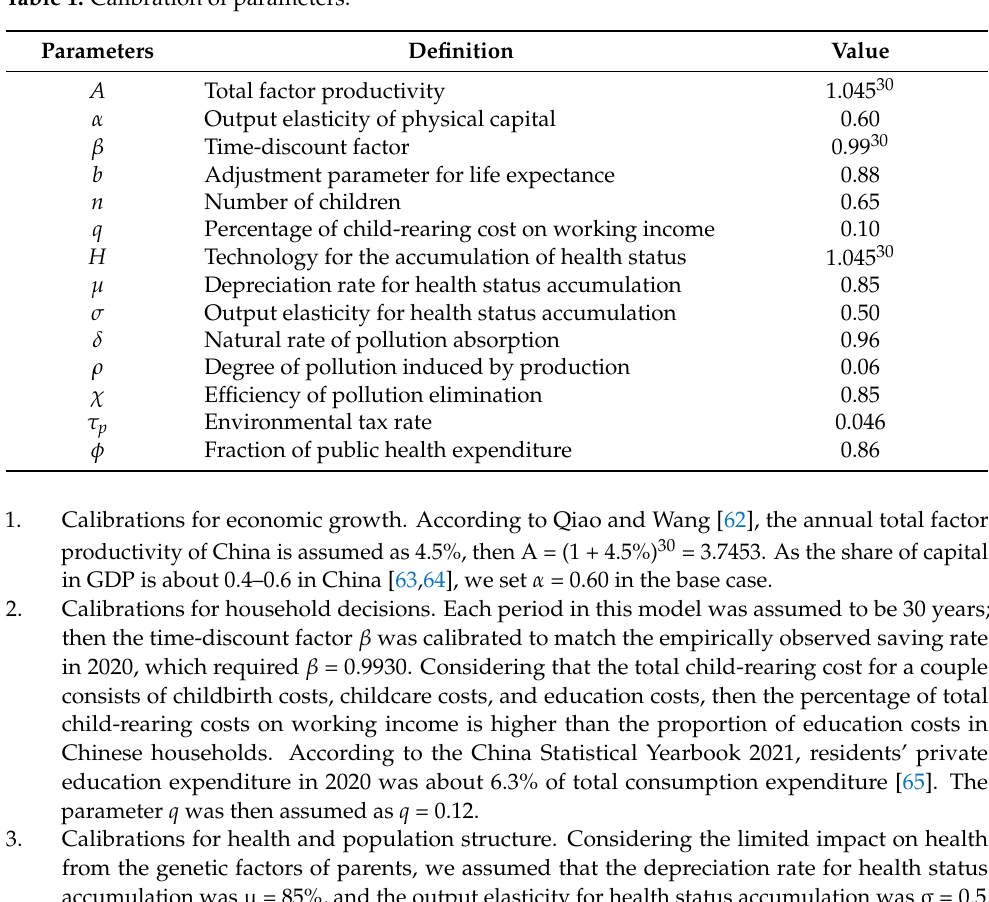
Table 1. Calibration of